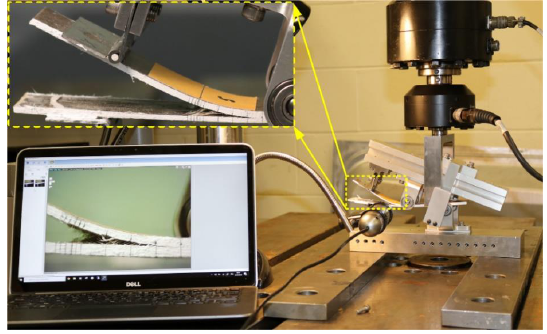
Figure 8. Mixed-mode I/II delamination test setup.